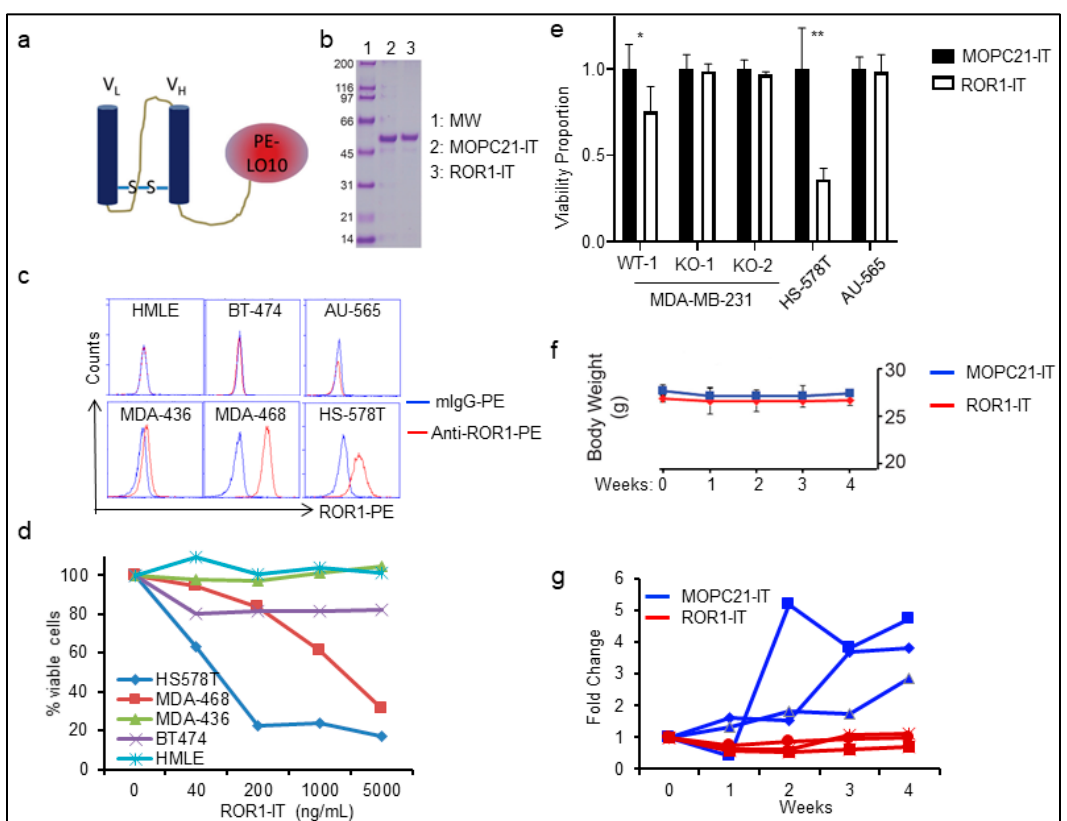
Figure 3. Targeting ROR1 + cancer cells with immunotoxin. ( a , b ) Construction and purification of anti-ROR1-immunotoxin by fusing variable region of anti-human ROR1 antibody (clone 2A2) with modified exotoxin A (PE lo10 ) from Pseudomonas aeruginosa ( a ), using variable region of MOPC21 (a non-specific mouse antibody)-fused with PE lo10 as control. Plasmids encoding ROR1-IT or MOPC21-IT were used to transform E. Coli for purification ( b ). ( c ) A panel of breast epithelial or cancer cells were screened for ROR1 expression by flow cytometry, including immortalized HMLE cells, three ROR1-negative (BT-474 and AU-565) or low (MDA-MB-436), and two ROR1-positive (MDA-MB-468 and Hs578T) cells. ( d ) Cells in c. were treated with different doses of ROR1-IT or MOPC-21-IT (0, 40, 200, 1000, 5000 ng/mL). 48 h later, cells were collected and stained with 7-AAD for viability and quantitated by flow cytometry ( n = 3, only data for ROR1-IT was shown here). ( e ) WT or KO cells of MDA-MB-231, ROR1 + Hs578T, or ROR1 − AU-565 cells were treated with 400 ng/mL of ROR1-IT or MOPC-21-IT for 48 h, following with counting of viable cells. ROR1-IT-treated cells were normalized to their corresponding MOPC-21-IT-treated cells ( n = 3). * p < 0.05; ** p < 0.001. ( f , g ) ROR1 +